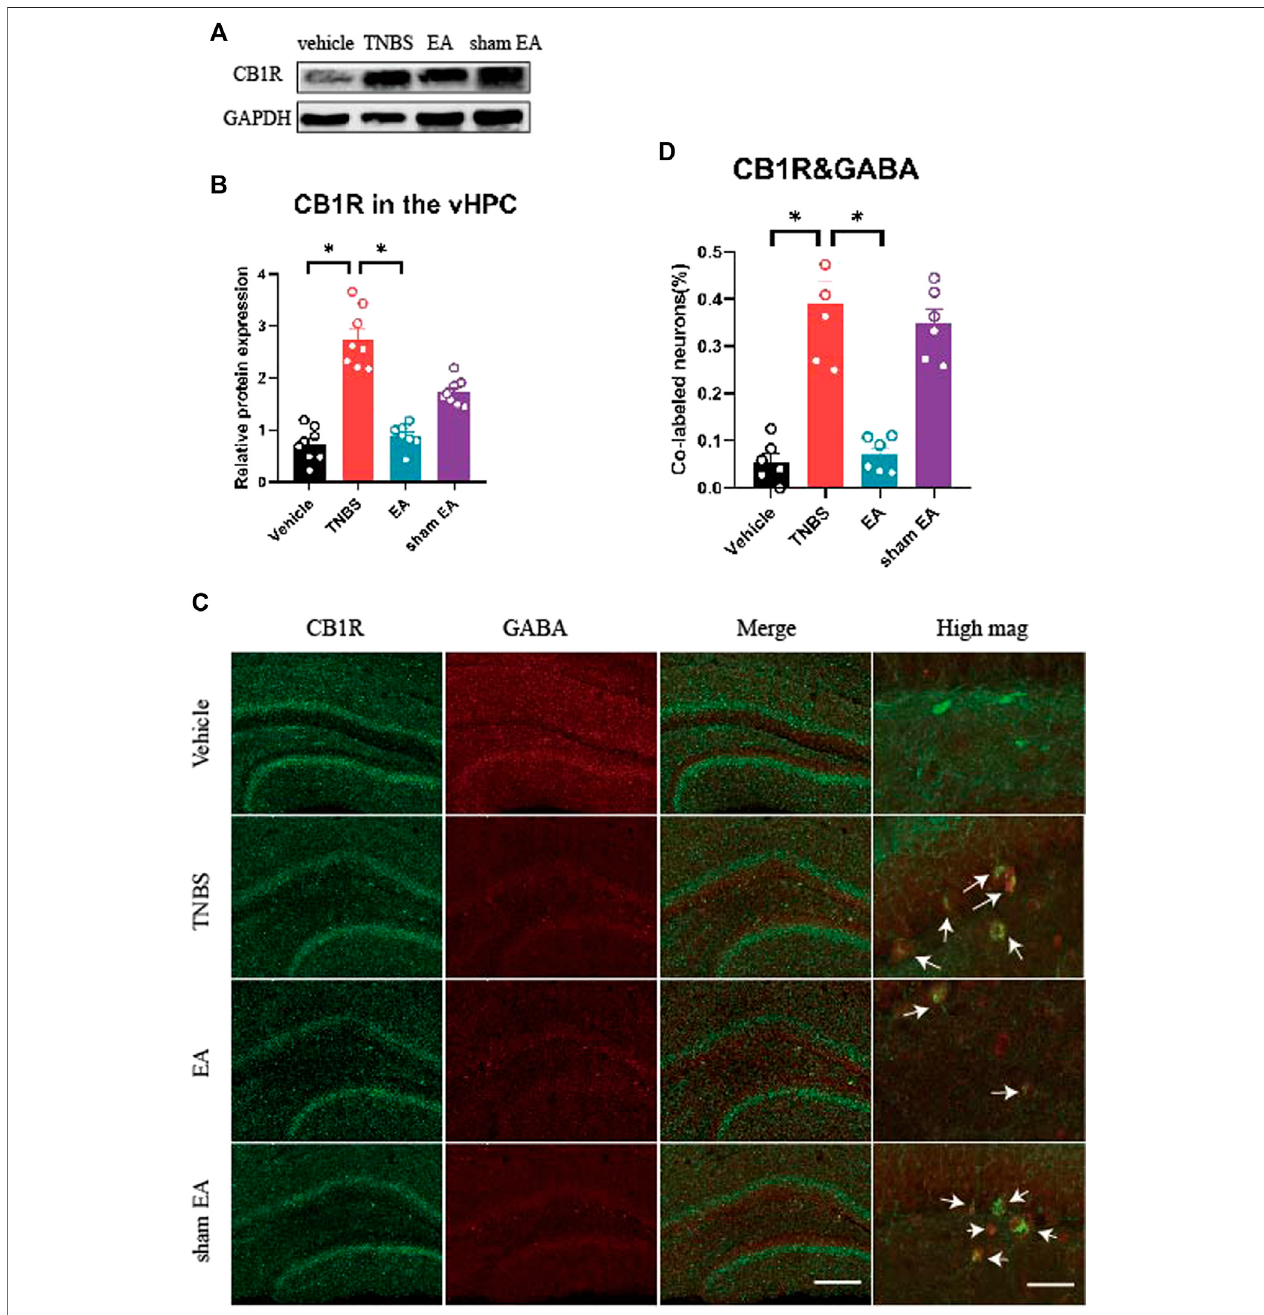
FIGURE 2 | EA reversed over-expression of CB1R and decreased the percentage of CB1R-expressed GABAergic neurons in the vHPC of IBD mice. (A) Representative immunoblots of CB1R and GAPDH protein expression in the vHPC. (B) Densitometric analysis of CB1R protein normalized to the loading control. (C) Immuno fl uorescenceimagesshowedCB1R(green)co-expressedwithGABA(red)inthevHPC. (D) PercentageofCB1R-expressedneuronsco-labeledwithGABA, which is (CB1R and GABA co-labeled neurons /total GABA neurons) *100%. Scale bar for merge images, 100 μ m. Scale bar for high magni fi cation images (high mag), 20 μ m. The data are expressed as mean ± SEM ( n = 9 mice). *represents p < 0.05 between marked groups.